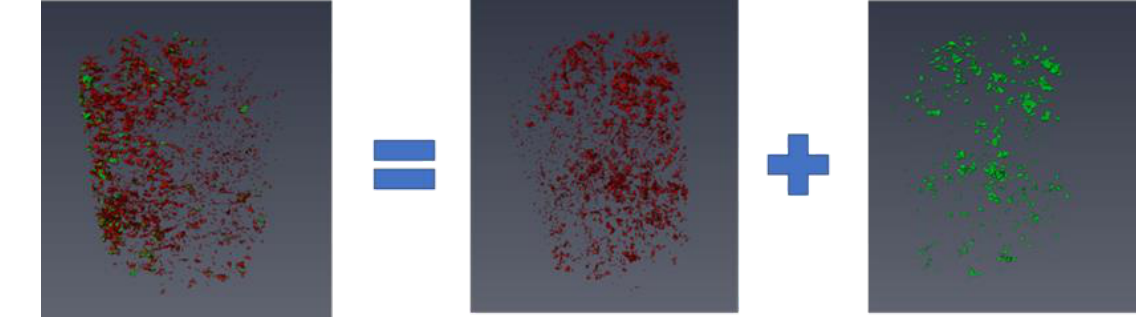
Figure 19. The first water flooding of the Y56 – 19 core.